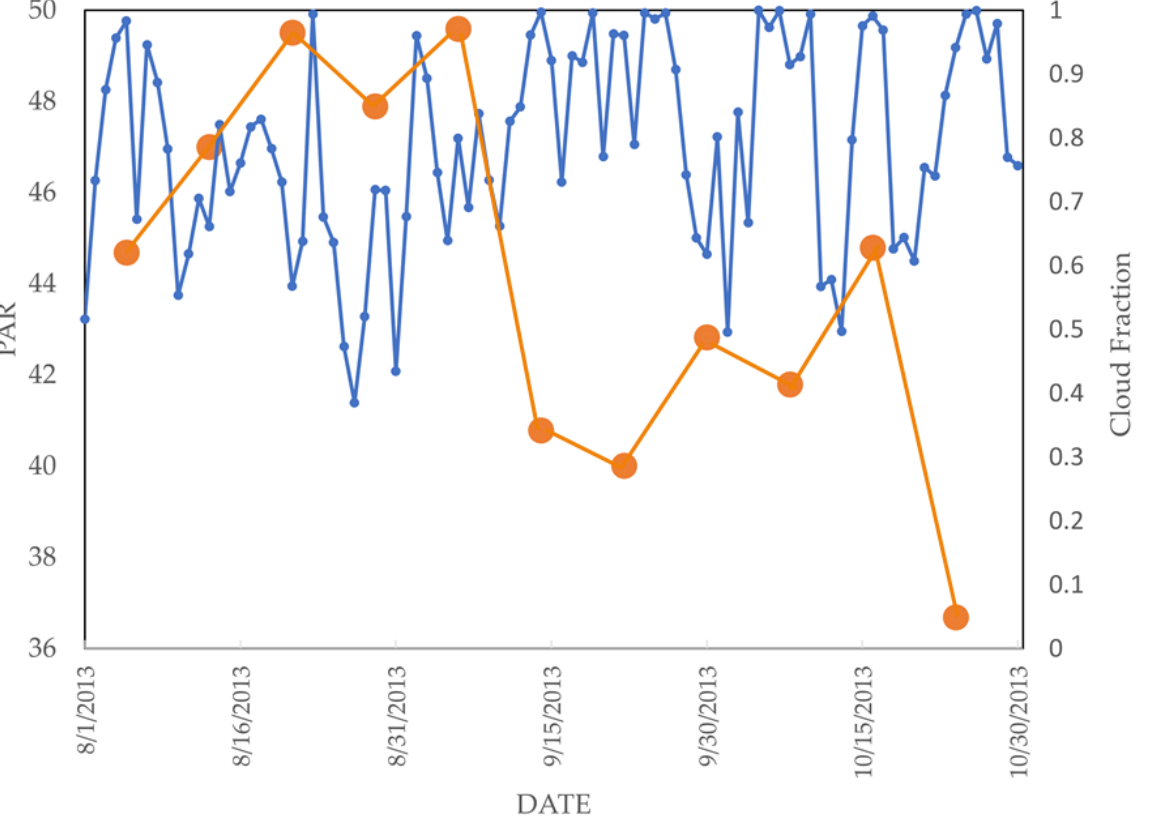
Figure 16. Time-series plot of daily MODIS-Aqua cloud fraction (blue) and MODIS-Aqua 8-day PAR for the Chuuk Lagoon region. This plot shows that the period of higher cloud cover from mid- to late September 2013 coincided with a period of lower PAR, and the periods of lower cloud cover in early- to mid-October coincided with higher PAR values. Units of PAR are Einstein/m 2 /day; cloud fraction is unitless from 0 to 1 (0% to 100% cloud cover).